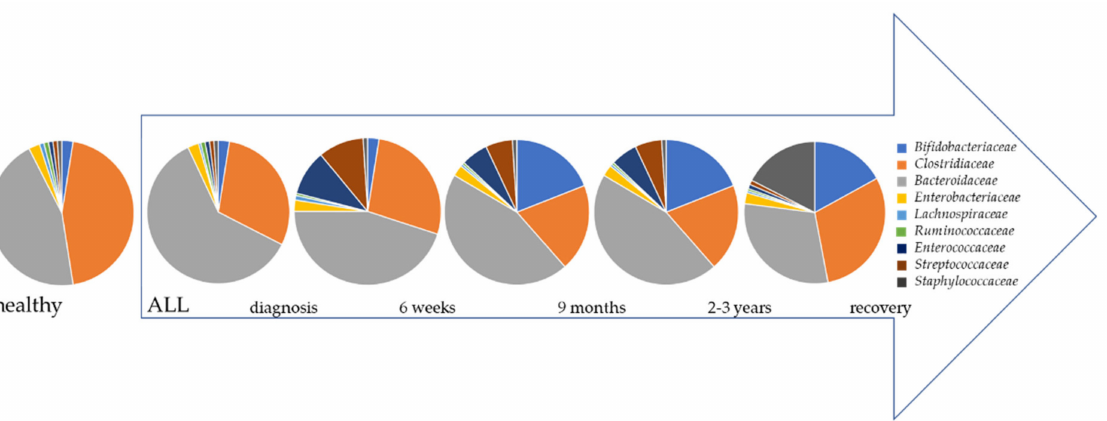
Figure 2. Microbial composition shifts during therapy phases. At timepoint of diagnosis composition already differs from ALL patients compared to healthy children. Clostridiaceae and Bacteroidaceae are predominant species in healthy children [31,48]. At time of diagnosis Bacteroidaceae abundance prevails in ALL patients while Clostridiaceae and Lach- nospiraceae decrease [31]. During the first 6 weeks of therapy namely induction phase, Ruminococcacea decrease, unlike Streptococcaceae and Enterococcaceae , whose abundances increase [35,36,38]. While bacterial load decreases in general within consolidation (9 months) and maintenance phase (2–3 years) the abundance of Lachnospiraceae and Clostridiceae decreases drastically, whereas spectrum of Bifidobacteriaceae, Streptococcacea, and Enterococcaceae emerged [35]. At the end of therapy microbial composition significantly differs from healthy children. ALL children still show an increase of Bifidobacteriaceae and Staphylococcaceae , and a decrease of Clostridiaceae and Bacteroidaceae [41]. This figure is a schematic representation and displays trends, not exact